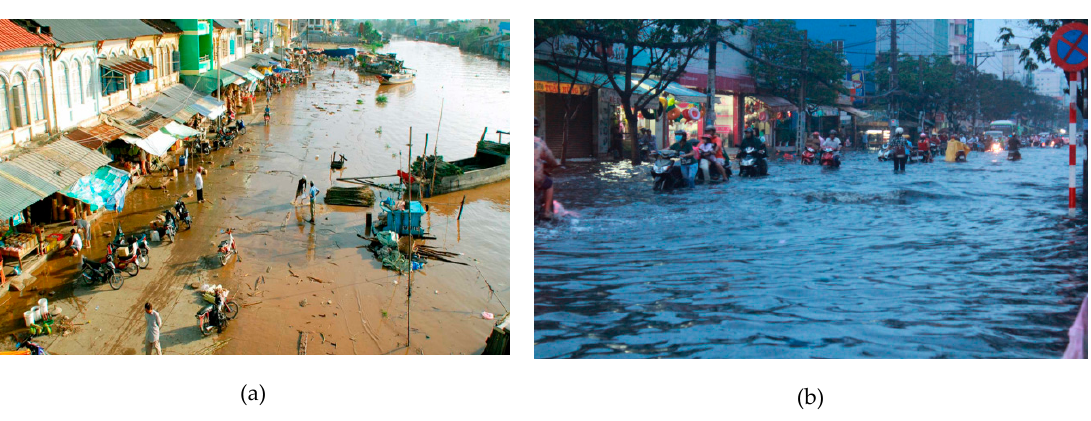
Figure 1. Flooding due to spring tides in the South province of Vietnam. ( a ) The center of Ca Mau province at the spring tide in 31 October 2010. ( b ) Ho Chi Minh City during the historic spring tide in 26 October 2011.